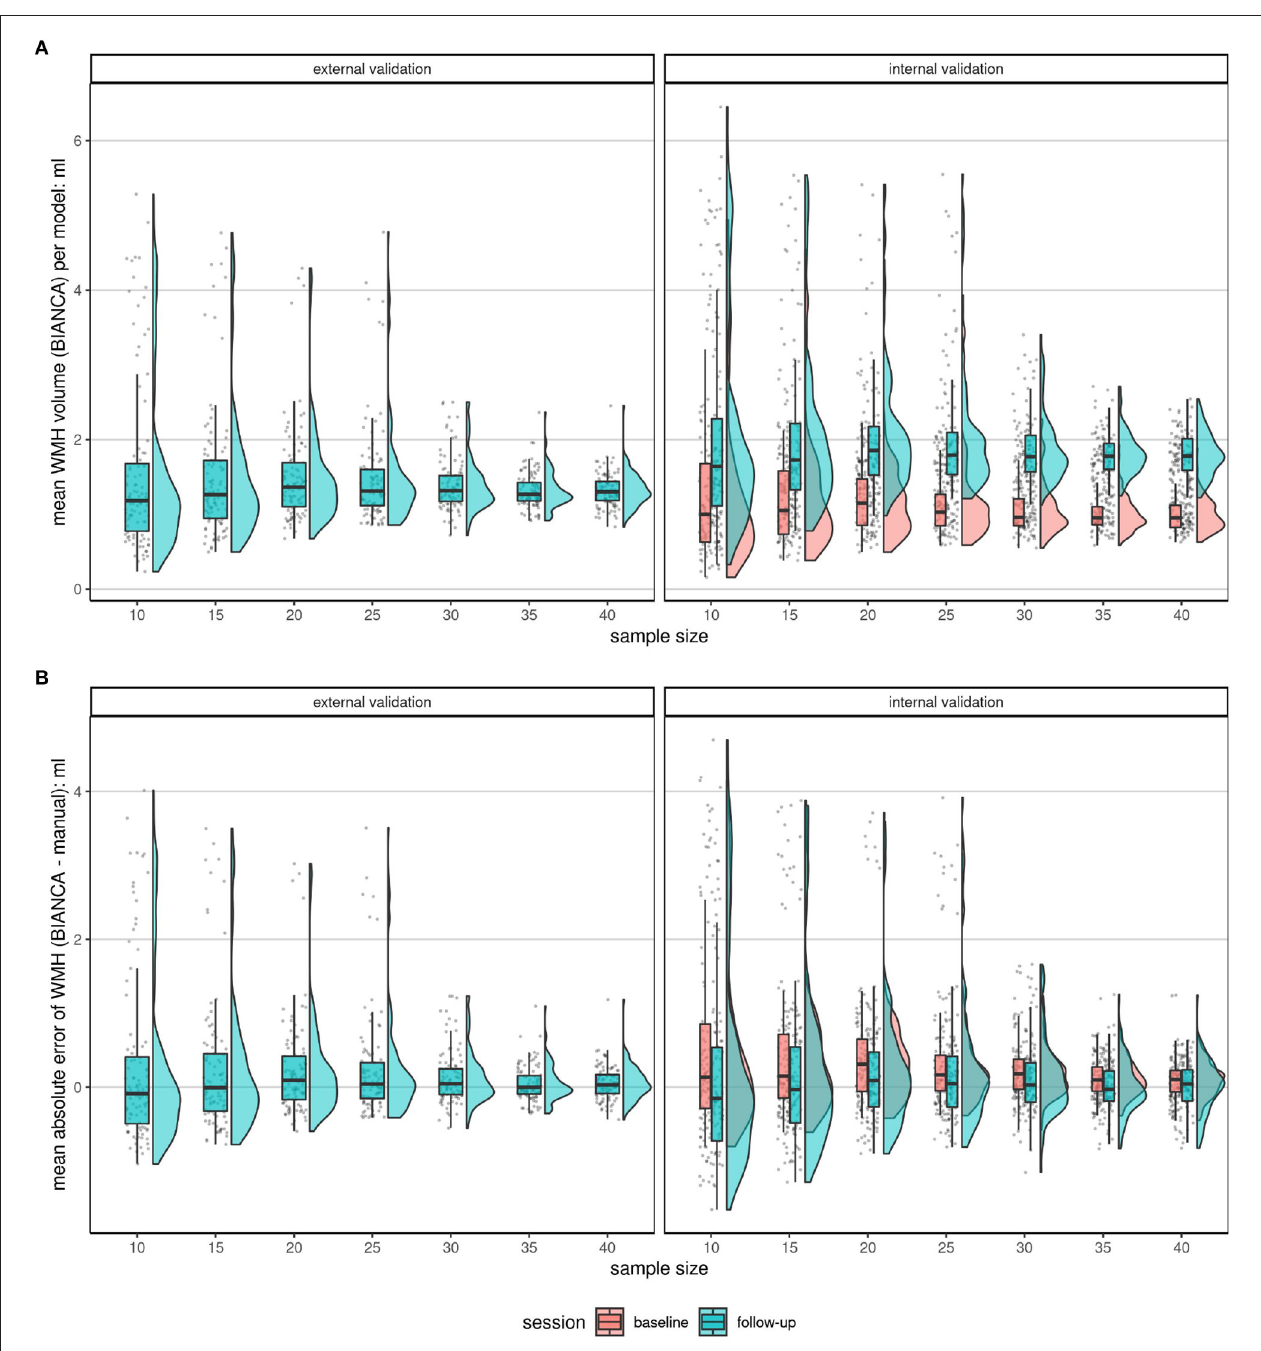
FIGURE 5 | Comparison of the mean BIANCA predicted volume (A) and mean absolute errors (B) of the two validation set types (internal validation set at BL and FU and external validation set) at increasing sample sizes at a threshold of 0.8. Shown are raincloud plots (Allen et al., 2019) of the mean BIANCA predicted volume (A) and the mean absolute error (B) by the model ( n = 100), sample size ( n = 7), and validation set ( n = 3). Both figures: The trend shows, that if more subjects were randomly chosen for the training of a BIANCA model, the performance (less outliers, closer IQR) in all sets becomes better. This shows a convergence of performance resulting in a more robust performance. (A): Mean absolute lesion volumes increase from BL to FU. (B): Mean absolute errors are on average larger (more positive) at BL compared to FU. Mean absolute errors greater than 0 point toward an overestimation of white matter hyperintensity volume by the automated segmentation with BIANCA, while mean absolute errors smaller than 0 hint toward an underestimation by BIANCA in comparison with the manual delineation performance (reference standard).